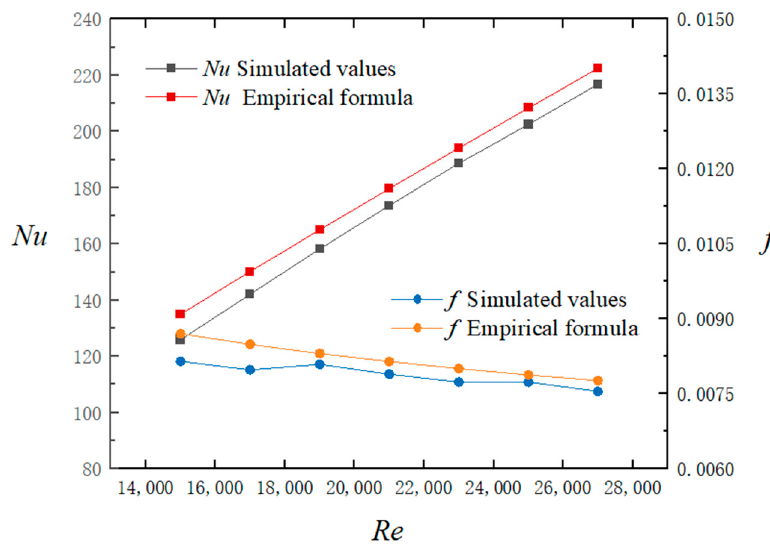
Figure 7. Verification of the numerical simulations in the helical pipe.